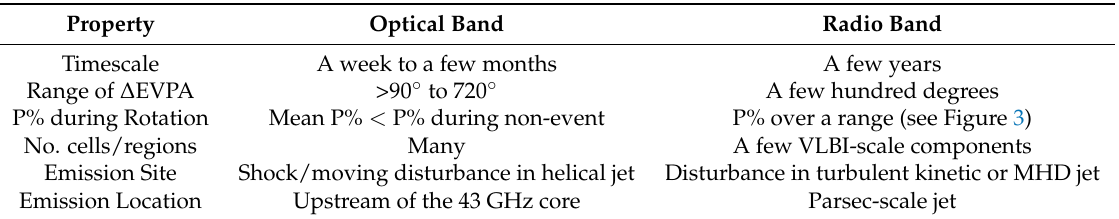
Table 1. Observed and Inferred Polarization Properties During Large EVPA Rotation